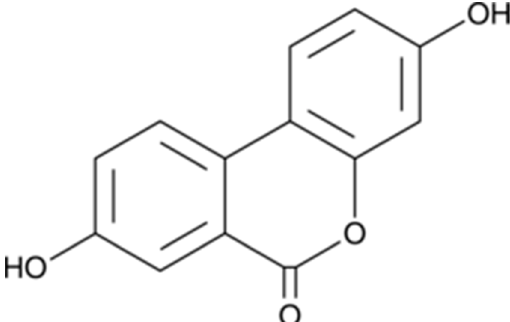
Figure 1. Structure of Urolithin A. Synonyms: 3,8-Dihydroxyurolithin; 3,8-Hydroxydibenzo- α -pyrone; 2 ′ ,7-Dihydroxy-3,4-benzocoumarin; δ -Lactone 2 ′ ,4,4 ′ -Trihydroxy-2-biphenylcarboxylic acid.